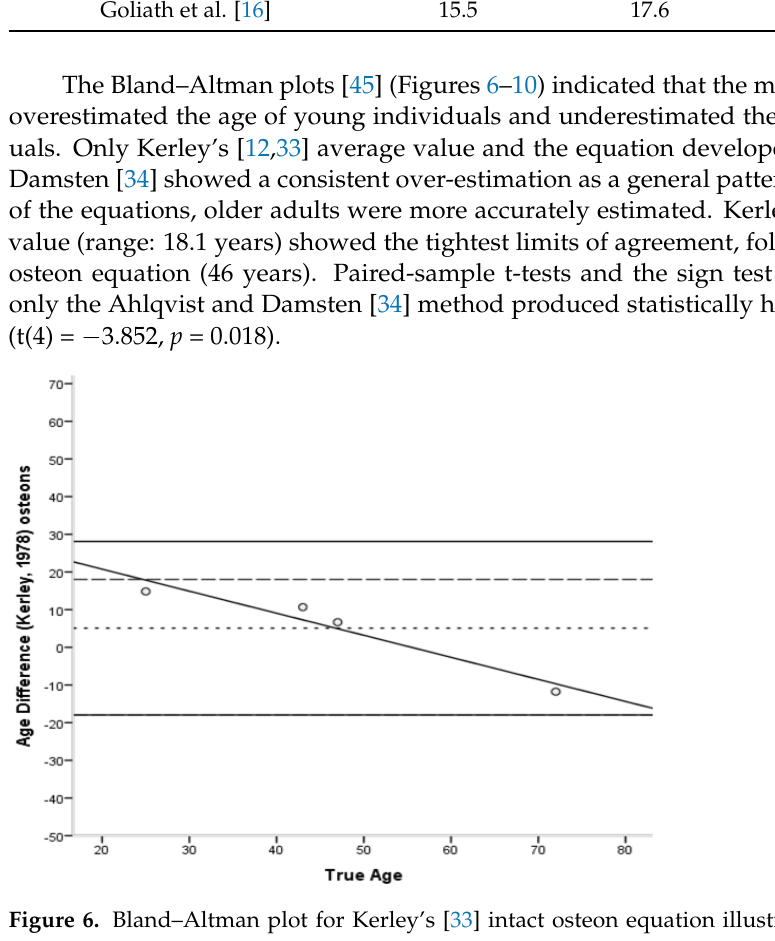
Figure 7. Bland –Altman plot for Kerley’s [33] % lamellar bone equation illustrating the differences between known and estimated ages for the femora against the known age. Depicted are 95% limits of agreement (black horizontal lines), mean difference/bias (black dotted line), best fit lines and 95% confidence intervals of the SEE for each method (dashed lines). R 2 of the best fit line: 0.978.